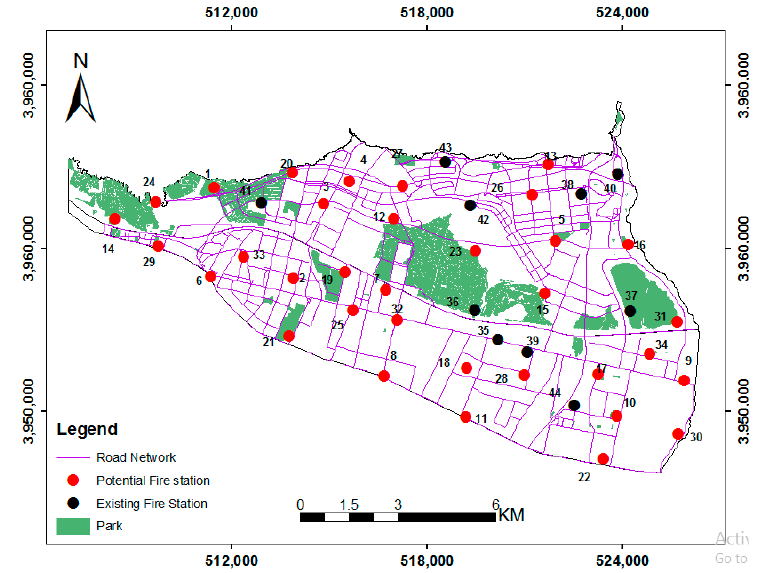
Figure 6. Location of candidate stations.